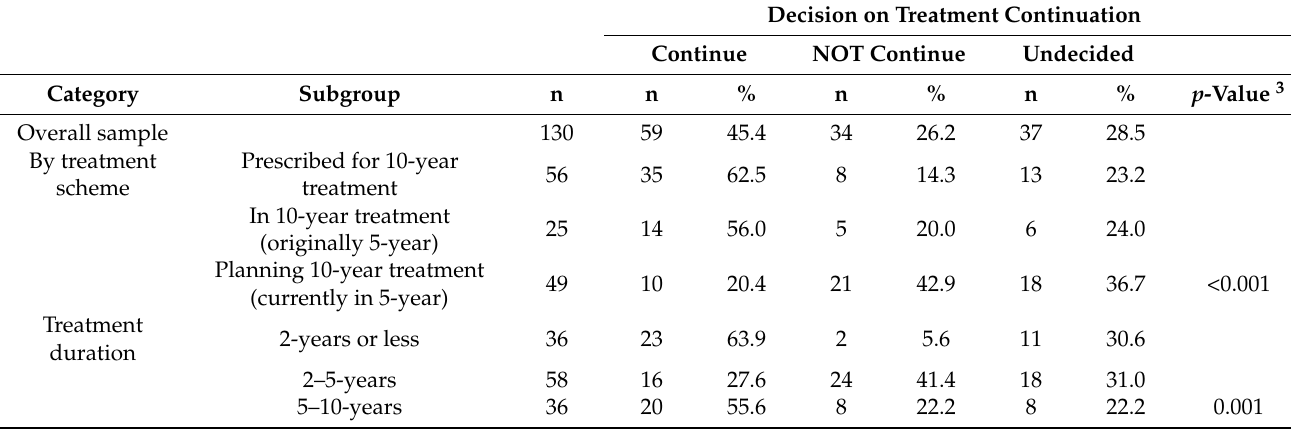
Table 1. Decision on treatment continuation overall and by treatment scheme, treatment duration, age, and family